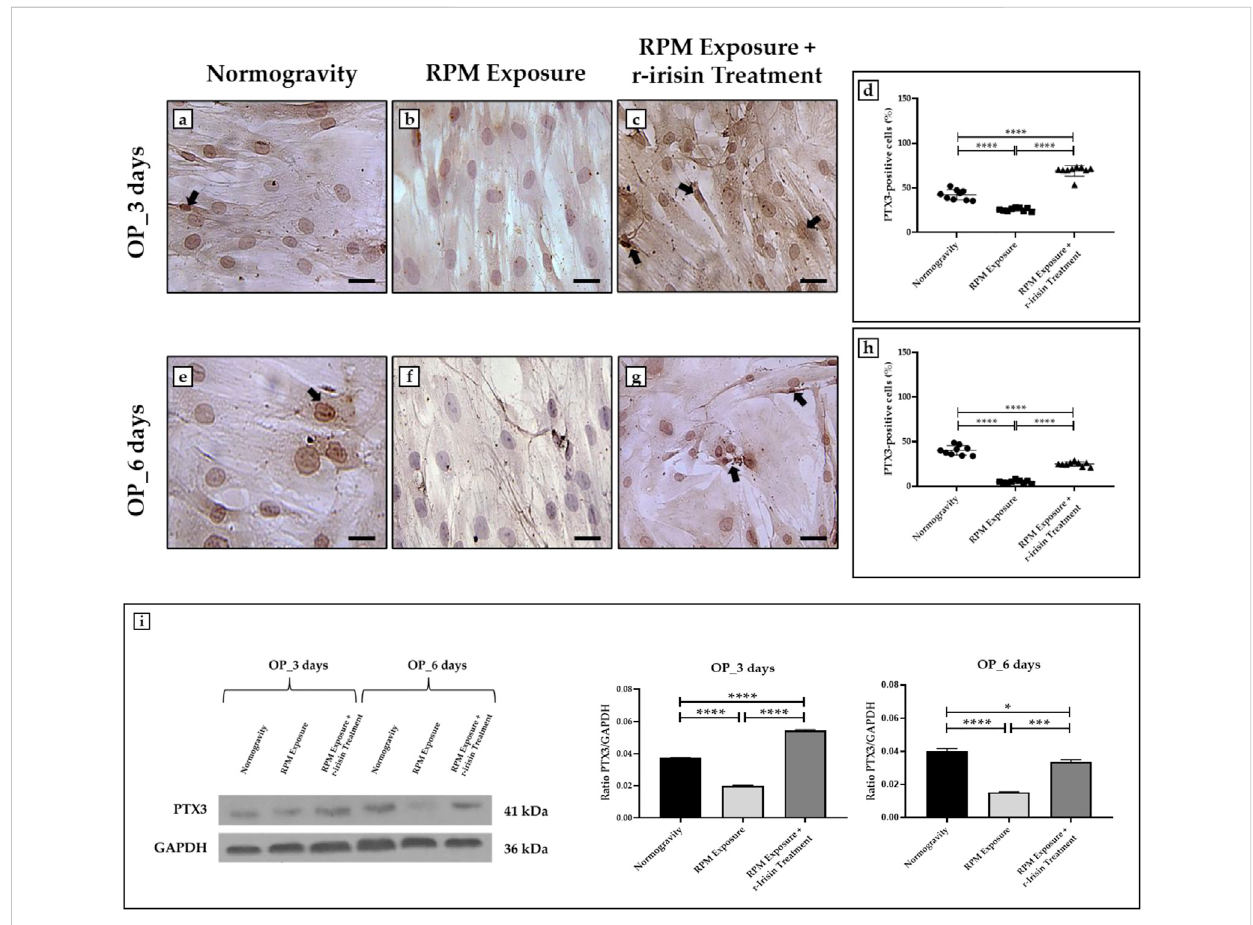
FIGURE 4 Effectsofrandompositioningmachine(RPM)exposureonthemineralizationprocessinprimaryosteoblast culturesderivedfromosteoporotic(OP) patients. (a – h) Immunocytochemical analysis for PTX3: (a – d) signi fi cant increase in PTX3 expression (arrows) in cells exposed to 3 days of RPM and treatedwithr-irisin; (e – h) PTX3expression(arrows)wasnotcompletelypreservedbyr-irisintreatment after 6 daysofRPM exposure. (i) Westernblotting analysis for PTX3: increased PTX3 expression in r-irisin-treated cells (3 days); PTX3 expression was not completely by r-irisin treatment in cells exposed to 6 days of RPM. Images were magni fi ed × 20, scale bar represents 50 μ m.